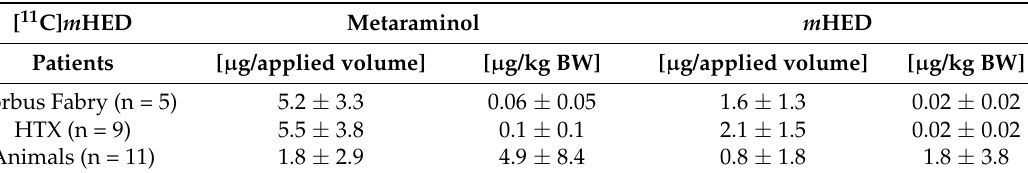
Table 2. Overview on the applied mass concentrations of the precursor metaraminol and m HED as well as applied mass per bodyweight (BW). None of the patients received more than 0.1 µ g/kg bodyweight of metaraminol and m HED, with a maximal administrated mass dose of 12 µ g metaraminol and 4.6 µ g m HED, respectively.